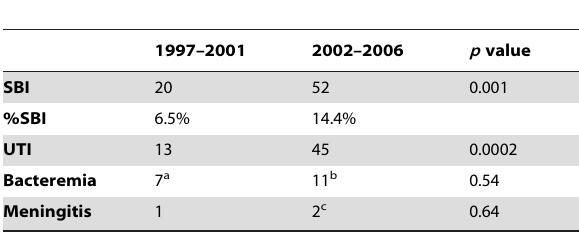
Table 2. Types of Serious Bacterial Infections in Early and Later periods.